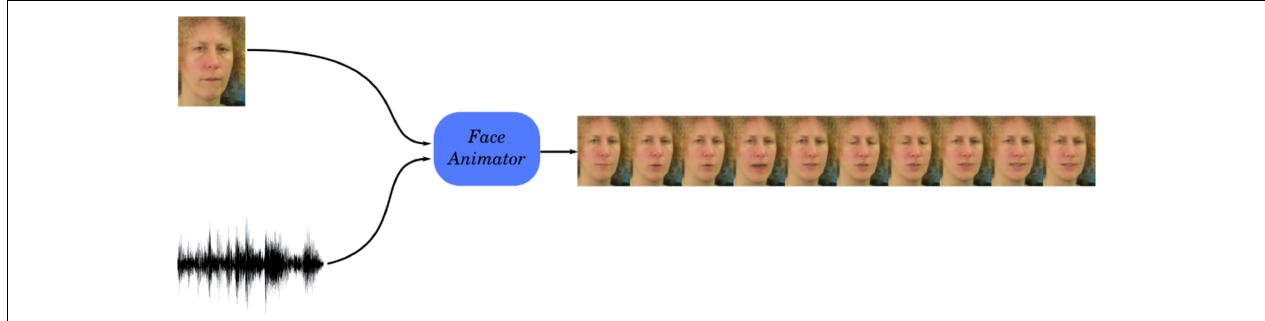
FIGURE 1 | Schematic of the generation of the facial animation. A GAN synthesizes a video of a talking face from a still image of the speaker and a speech signal. Source: adapted from the GRID corpus (available at: https://doi.org/10.5281/zenodo.3625687) under CC-BY 4.0 license.